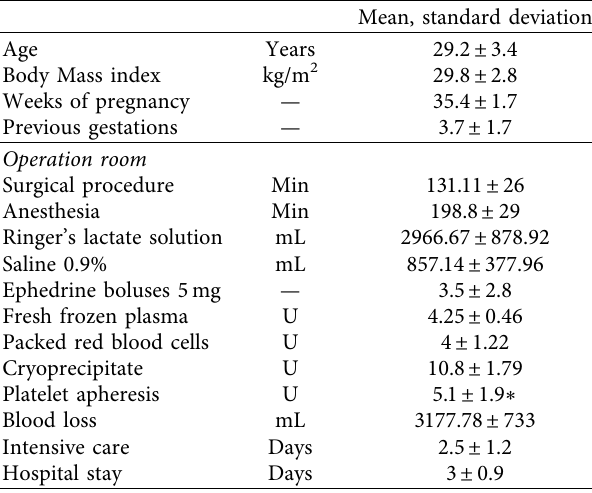
Table 2: Sample demographic characteristics of the